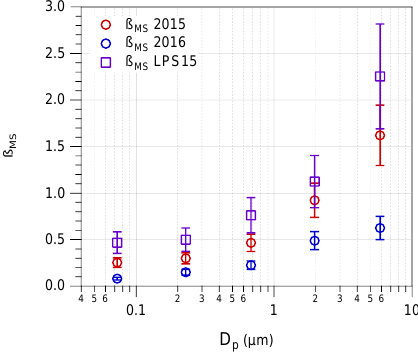
Figure 13. Mean size-segregated results for the MS − / nss–SO 2 − mass ratio β MS determined for each of the five impactor stages for both seasons and for the event